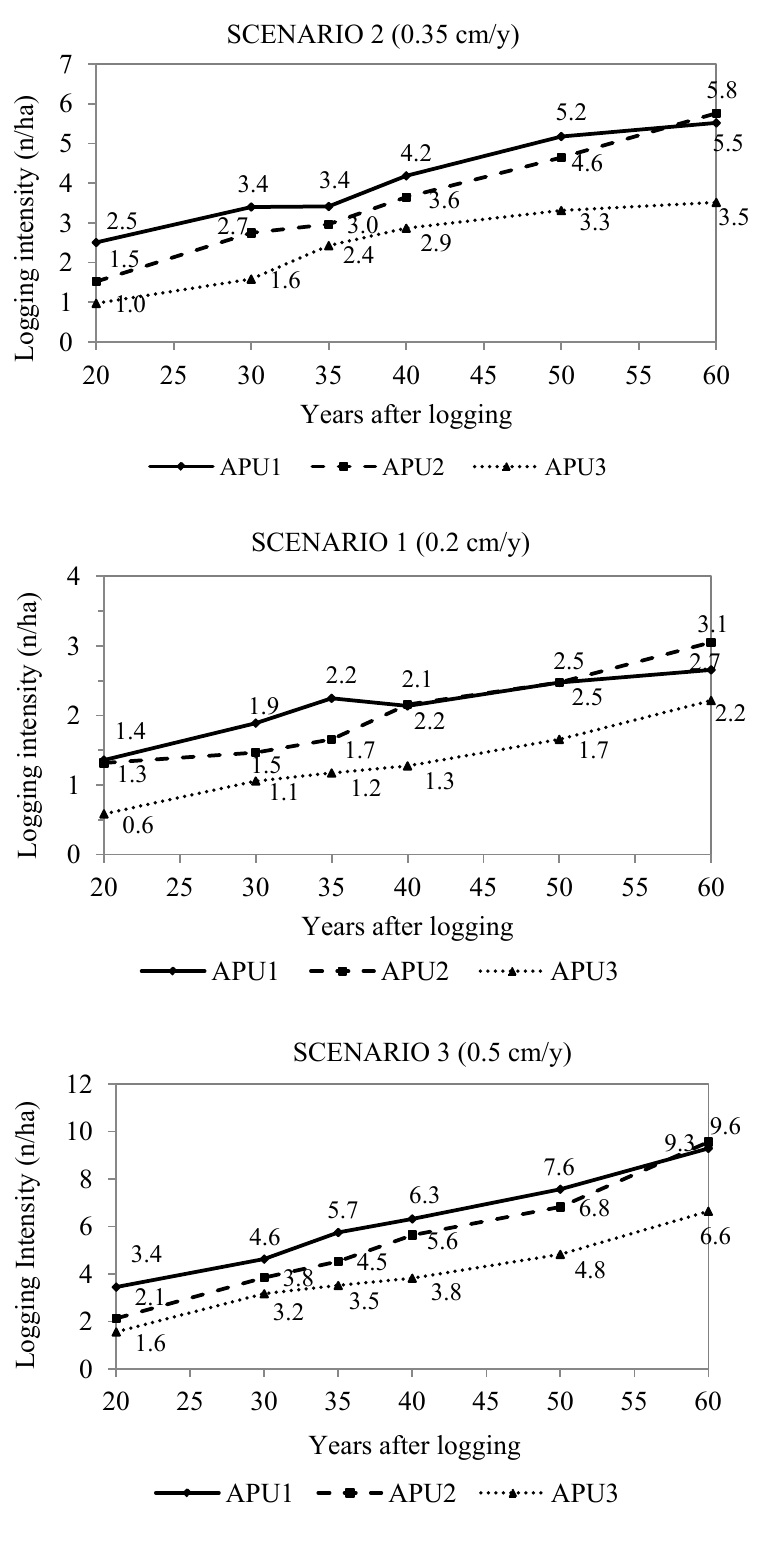
Figure 2. Recovery rates of timber stocks according to the three diameter growth rate scenarios Logging intensity = number of potentially harvestable